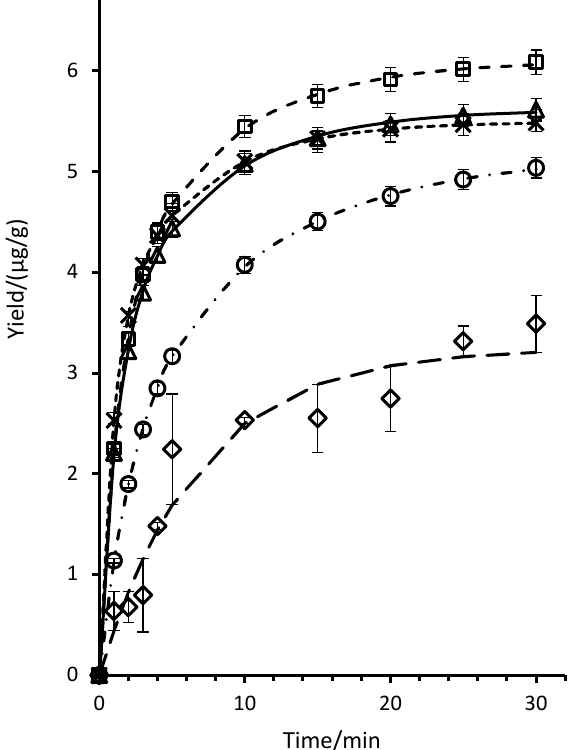
Figure 6. The extraction progress plot of β-asarone at solid-to-solvent ratio 1:50 with sonication power of 70 (□), 50 (×), 30% (∆), and with the presence of temperature ( ○ ) and without (◊). The lines were plotted with the calculated value according to Equation (1) for sonication power of 70 (dashed line), 50 (dotted line), 30% (straight line), and in the absence of sonication with the presence of temperature (dash-dot line) and without (long dashed line). Table 1. The extract yield, Y t of the extraction in the presence and absence of ultrasound. The values of c w , k w , c d and k d